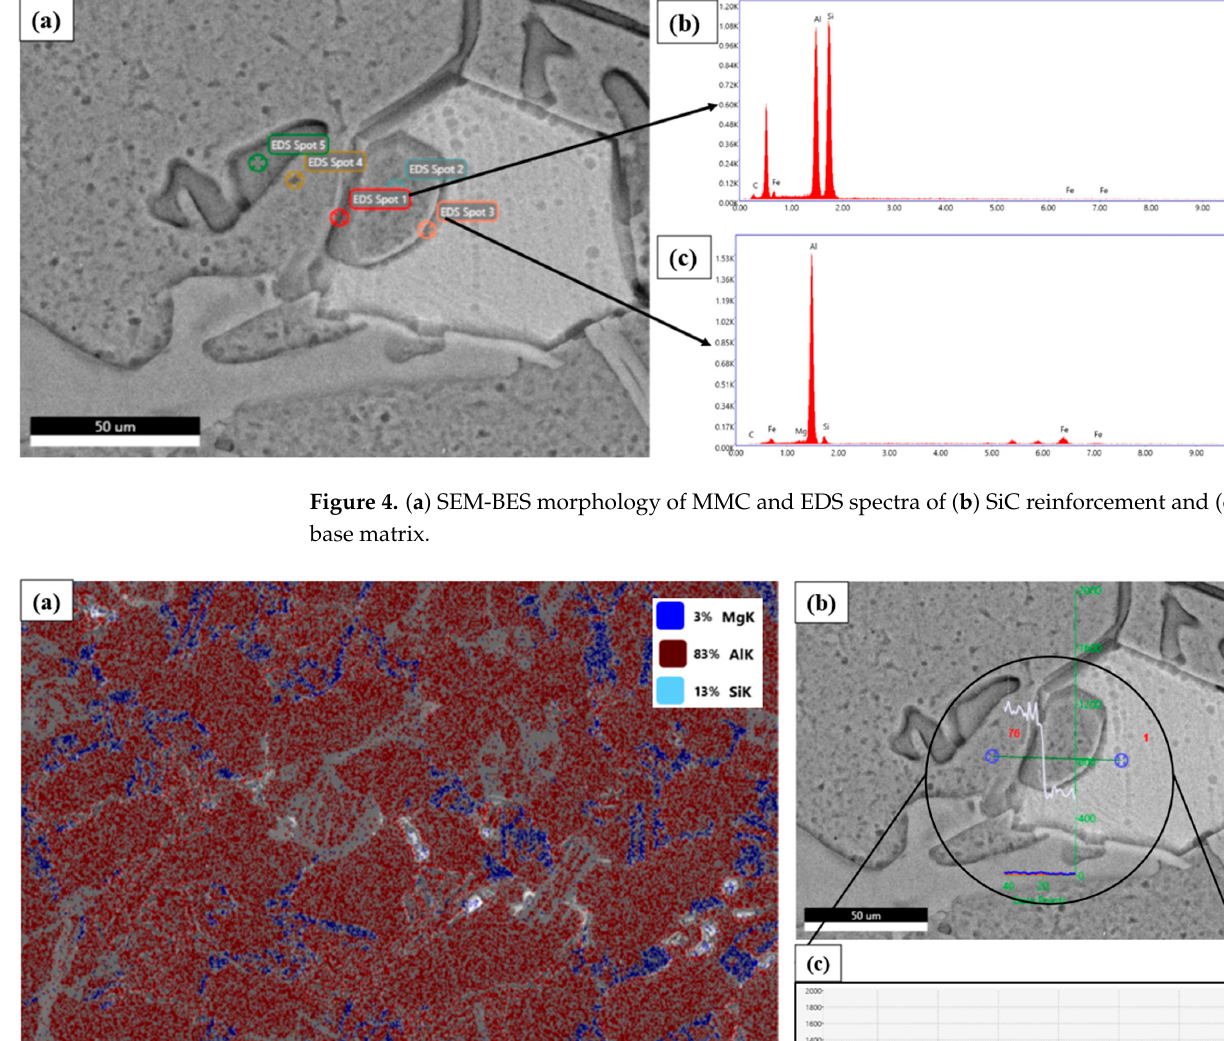
10 of 19 Figure 3. Al-Si phase diagram . 3.2. Compositional and Phase Analysis of Fabricated MMC though SEM, EDS, and XRD The EDS analysis of the fabricated MMC was obtained with the intention of accu- rately estimating the compositional variation and distribution. Furthermore, EDS analysis lays down the foundation to conduct the investigation on detecting the elements present, which can further be con fi rmed by the successful analysis of XRD peaks. The EDS spot analysis as shown in Figure 4 displays an expected behaviour, with the EDS peak repre- sented in Figure 4b with a darker grey tone in colour revealing high peaks of Al, Si, and C; this indicates the morphological feature to be SiC reinforcements. Similarly, the second